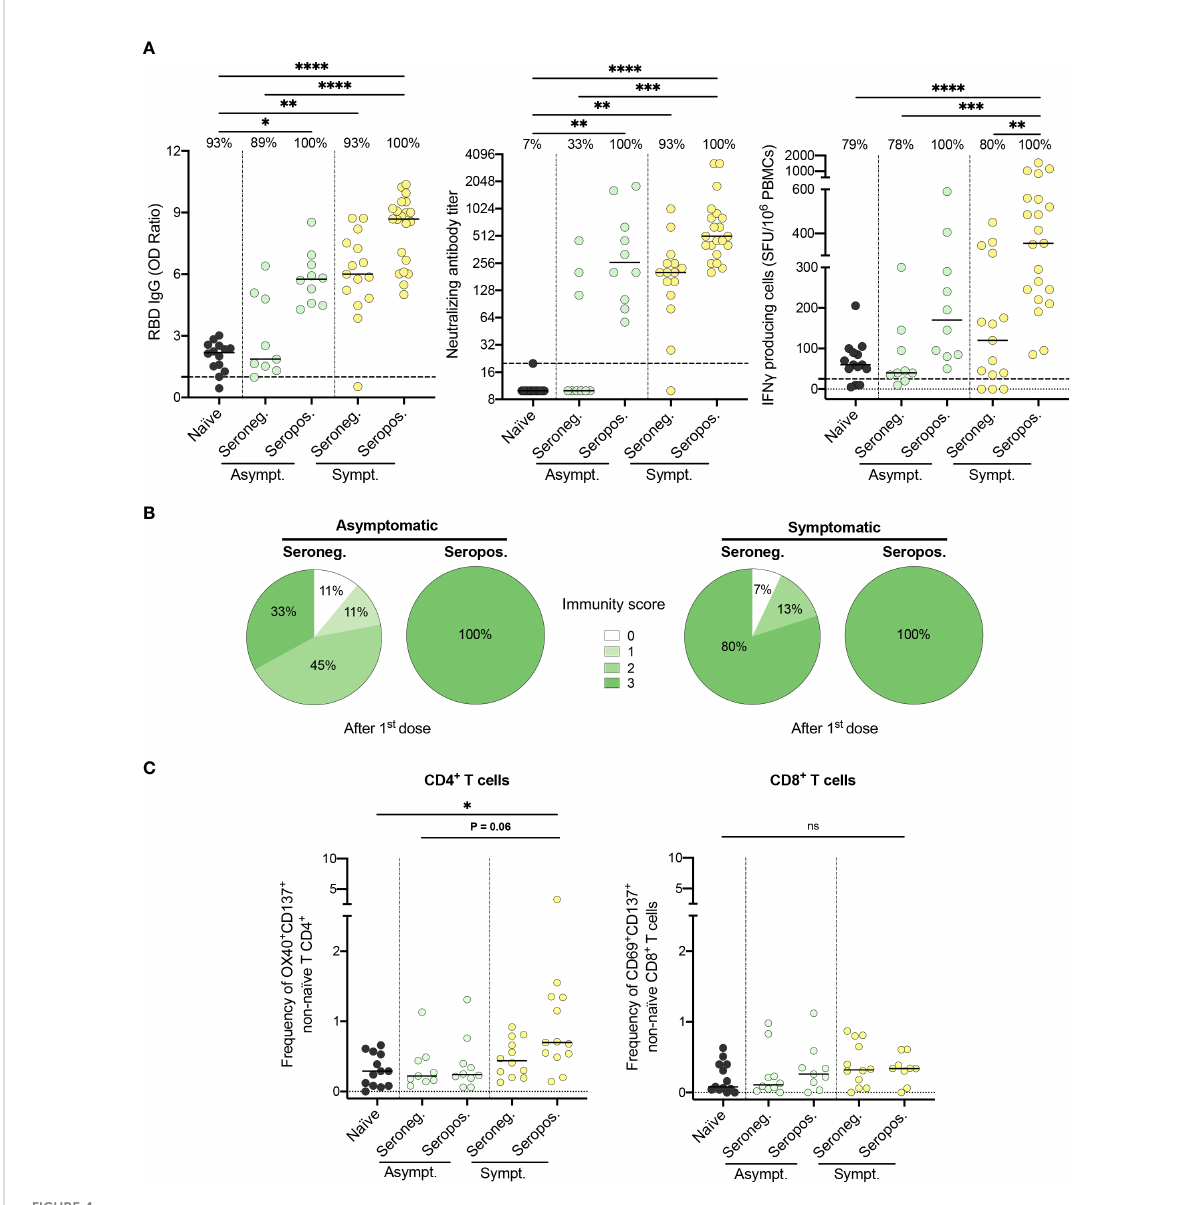
FIGURE 4 Both symptomatology during infection and serostatus prior to vaccination in fl uence the immunogenicity of the fi rst vaccine dose. (A) SARS- CoV-2 Spike RBD – speci fi c binding IgG levels assessed by ELISA (left panel), SARS-CoV-2 neutralizing antibody titers (middle panel), and IFN- g secreting cells per million in response to SARS-CoV-2 Spike glycoprotein peptides assessed by ELISpot (right panel) for naïve (black circles), seronegative (Seroneg.) (n=24) and seropositive (Seropos.) (n=31) recovered HCWs after one dose of vaccine. Asymptomatic recovered HCWs (Asympt.) are represented with green circles (n=19) and symptomatic HCWs (Sympt.) with yellow circles (n=36). Dashed black lines indicate the positive threshold value, and the percentage of HCWs with responses above positive threshold value is indicated for each assay. (B) Pie charts of calculated immunity score for asymptomatic (left panel) and symptomatic (right panel) recovered HCWs after one dose of vaccine. (C) Frequency of SARS-CoV-2 − Spike-speci fi c T cells measured as percentage of OX40 + CD137 + non-naïve CD4 + (left panel) and CD69 + CD137 + non-naïve CD8 + T cells (right panel) after stimulation of PBMCs with CD4-S mega pool of peptides from the Spike glycoprotein for naïve (n=13), asymptomatic seronegative (n=9) or seropositive (n=10) and symptomatic seronegative (n=12) or seropositive (n=13) recovered HCWs after one dose of vaccine. Horizontal bars indicate the median of each group. Kruskal-Wallis tests assessed statistical signi fi cance (A-C) . Not signi fi cant (ns) P >.05; *P < .05; **P <.01; ***P < .001; ****P <